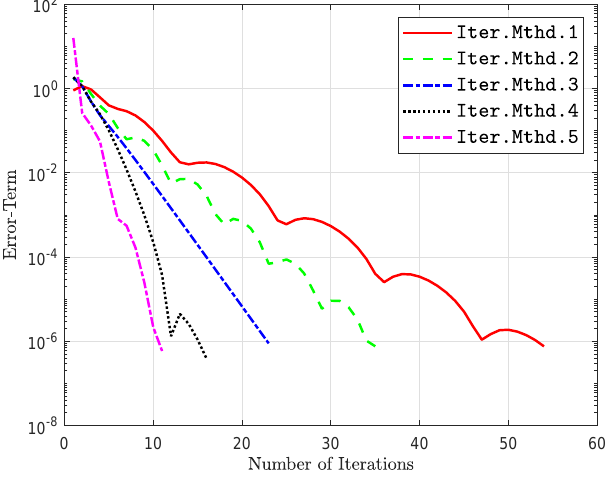
Figure 11. All techniques are computationally examined while s 0 = ( 2, − 1,3,2,5 ) T .